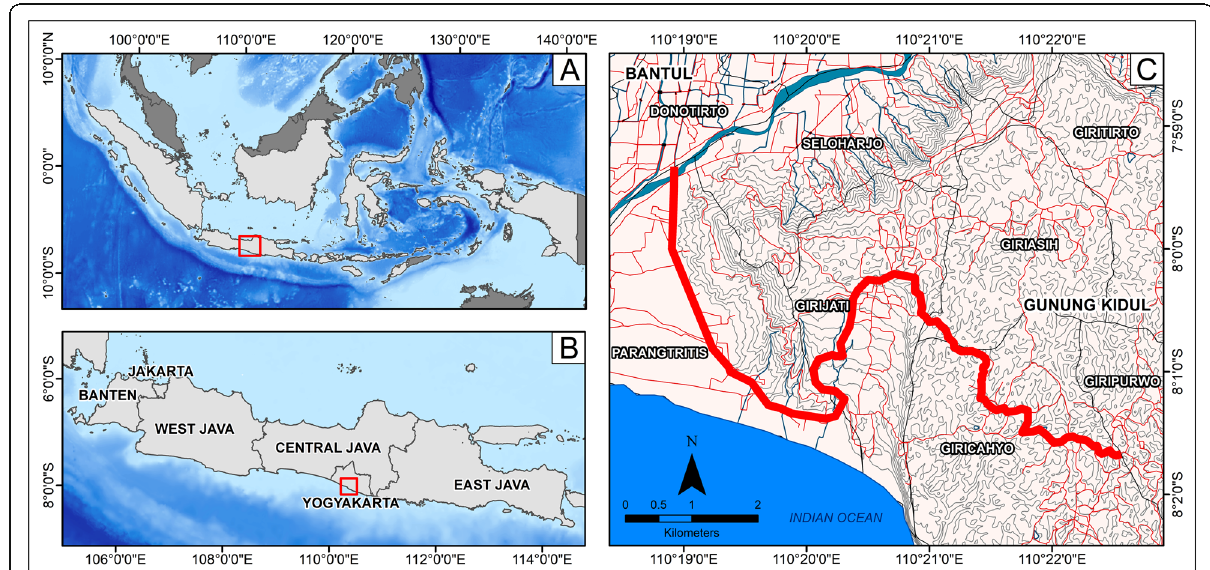
Fig. 1 The maps of ( a ) Indonesia; b Java Island; and c the study area. The thick red line on map ( c ) represents the road segment to be